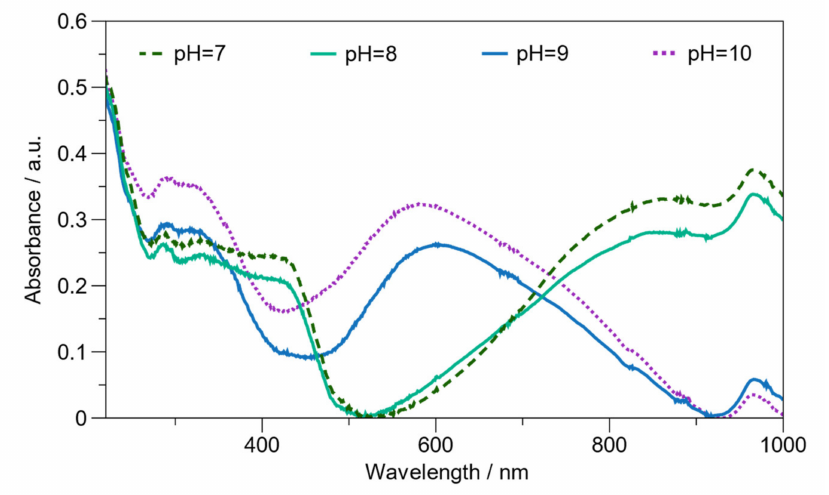
Figure 6. UV–Vis spectra of BL PAni, in water, and in the range where the doping point occurs from pH 7 to pH